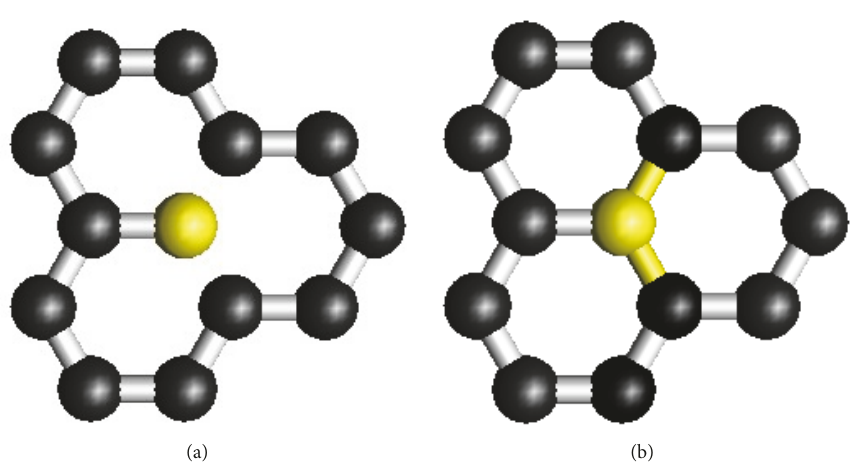
Figure 12: Automatic chemical bond